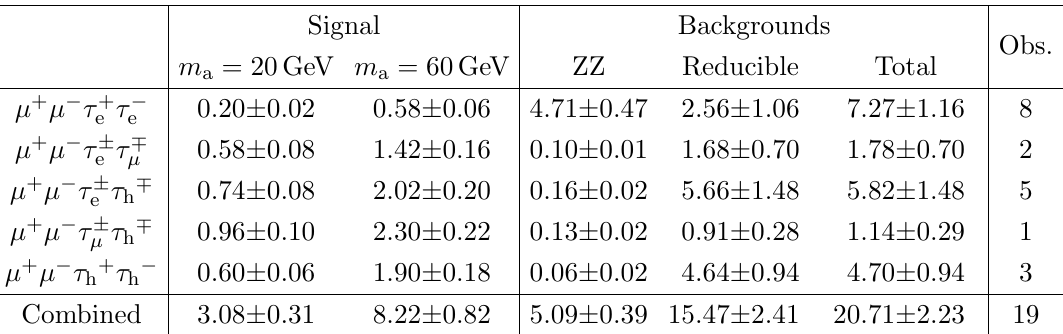
Figure 3 . Background and signal ( m a = 35 GeV) models, scaled to their expected yields, for the combination of all (cid:12)nal states ( (cid:22) + (cid:22) (cid:0) (cid:28) + (cid:22) + (cid:22) (cid:0) (cid:28) h+ (cid:28) h (cid:0) ) in the search for h ! aa ! 2 (cid:22) 2 (cid:28) decays. The two components of the background model, ZZ and reducible processes, are drawn. The signal sample is scaled with (cid:27) h as predicted in the SM, assuming B (h ! aa) = 10%, and considering decays of the pseudoscalar a boson to leptons only ( B (a ! (cid:28) + (cid:28) (cid:0) ) + B (a ! (cid:22) + (cid:22) (cid:0) ) + B (a ! e + e (cid:0) ) = 1) using eq. (1.1). The results are shown after a simultaneous maximum likelihood (cid:12)t in all (cid:12)ve channels that takes into account the systematic uncertainties described in section 6.